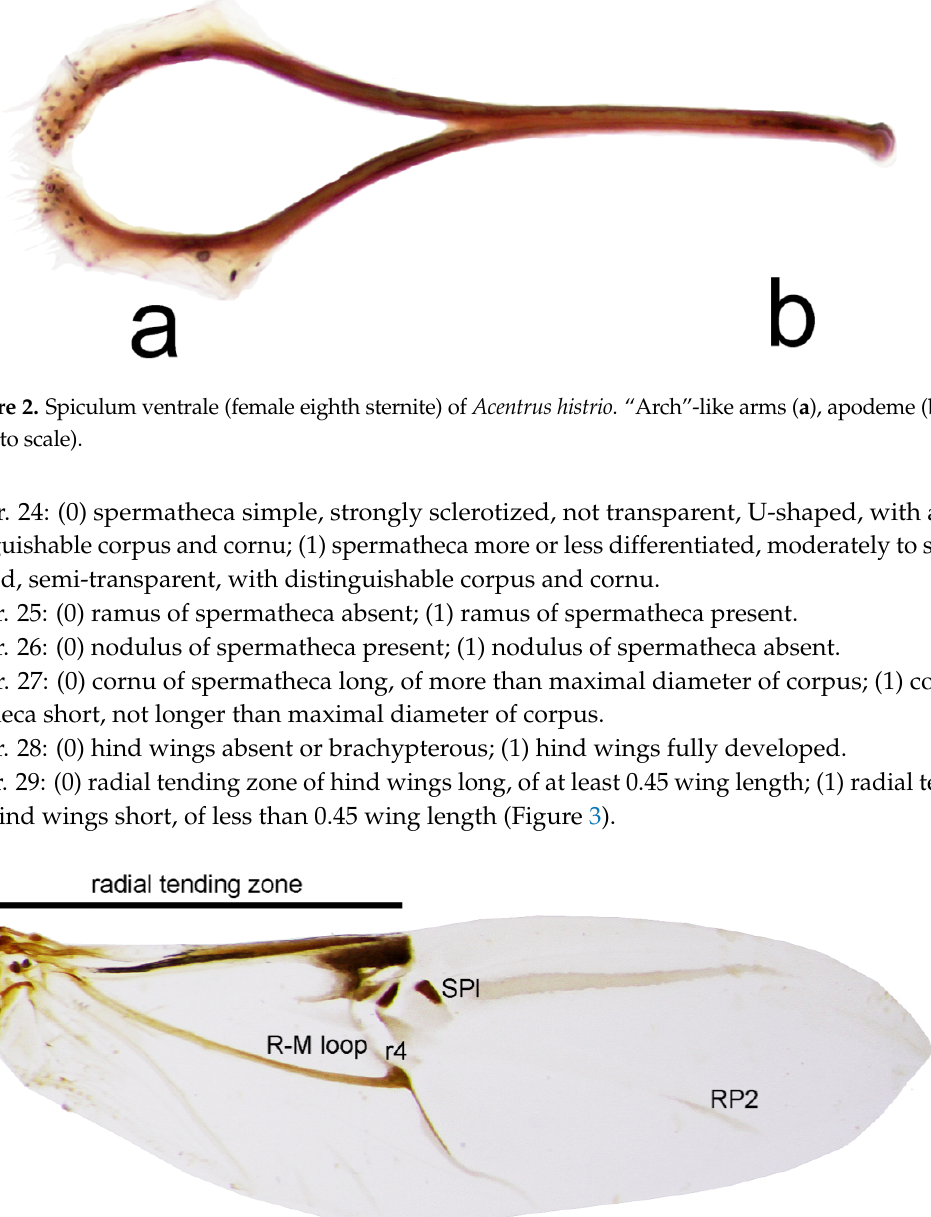
Figure 3. Hind wing of Acentrus histrio. Lateral sclerotized plate (SPl), radio-medial loop (R–M loop), radius posterior 2 (RP2), r4 vein (r4). (Not to scale).